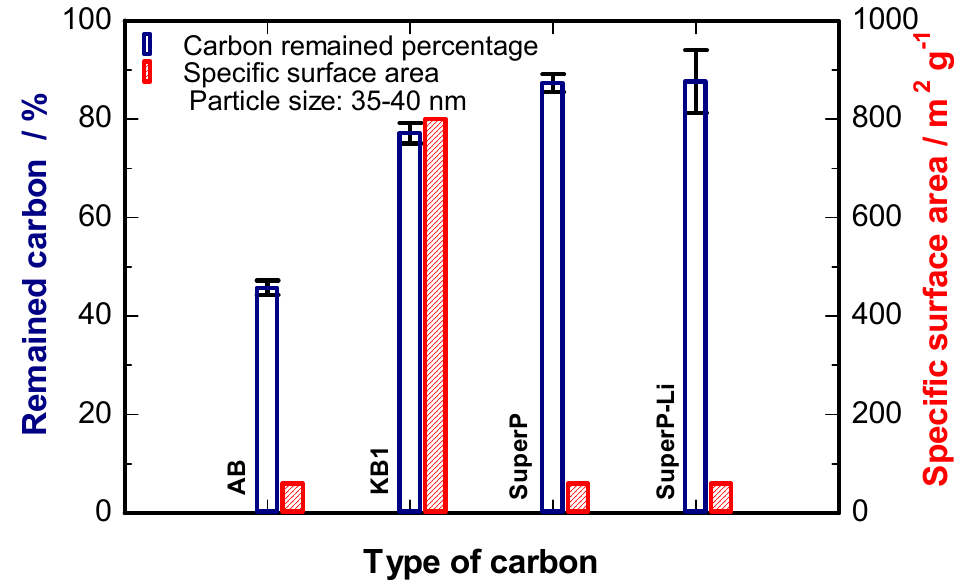
Figure 6. Remaining carbon percentage of cathodes using four types of carbon after the carbon stability test. Those carbons have similar particle shape and size (35–40 nm).